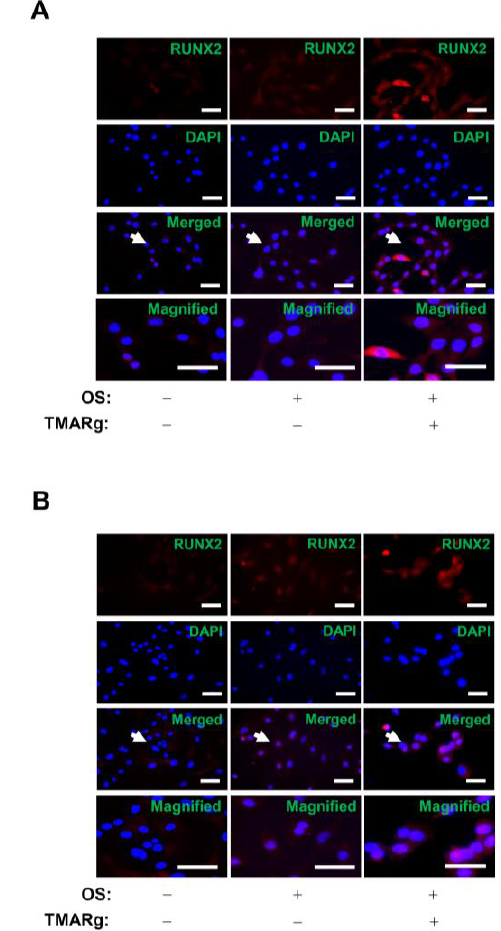
Figure 5. TMARg accumulates the expression of RUNX2 into the nucleus in osteoblast differentiation. ( A , B ) After mesenchymal cells ( A ) and pre-osteoblasts ( B ) were cultured in OS with TMARg (30 µM) for 24 h, the cells were fixed and permeabilized. RUNX2 was immunostained with rabbit anti-RUNX2 antibody, followed by Alexa-Fluor 568-conjugated secondary antibody (red). Then, the cells were counterstained with DAPI (blue). The third panel shows the merged images of the first and second panels. The bottom panels show the magnifications of the merged images. The arrow indicates the magnified region. Scale bar: 50 µm. The data are representative of the results of three independent experiments.